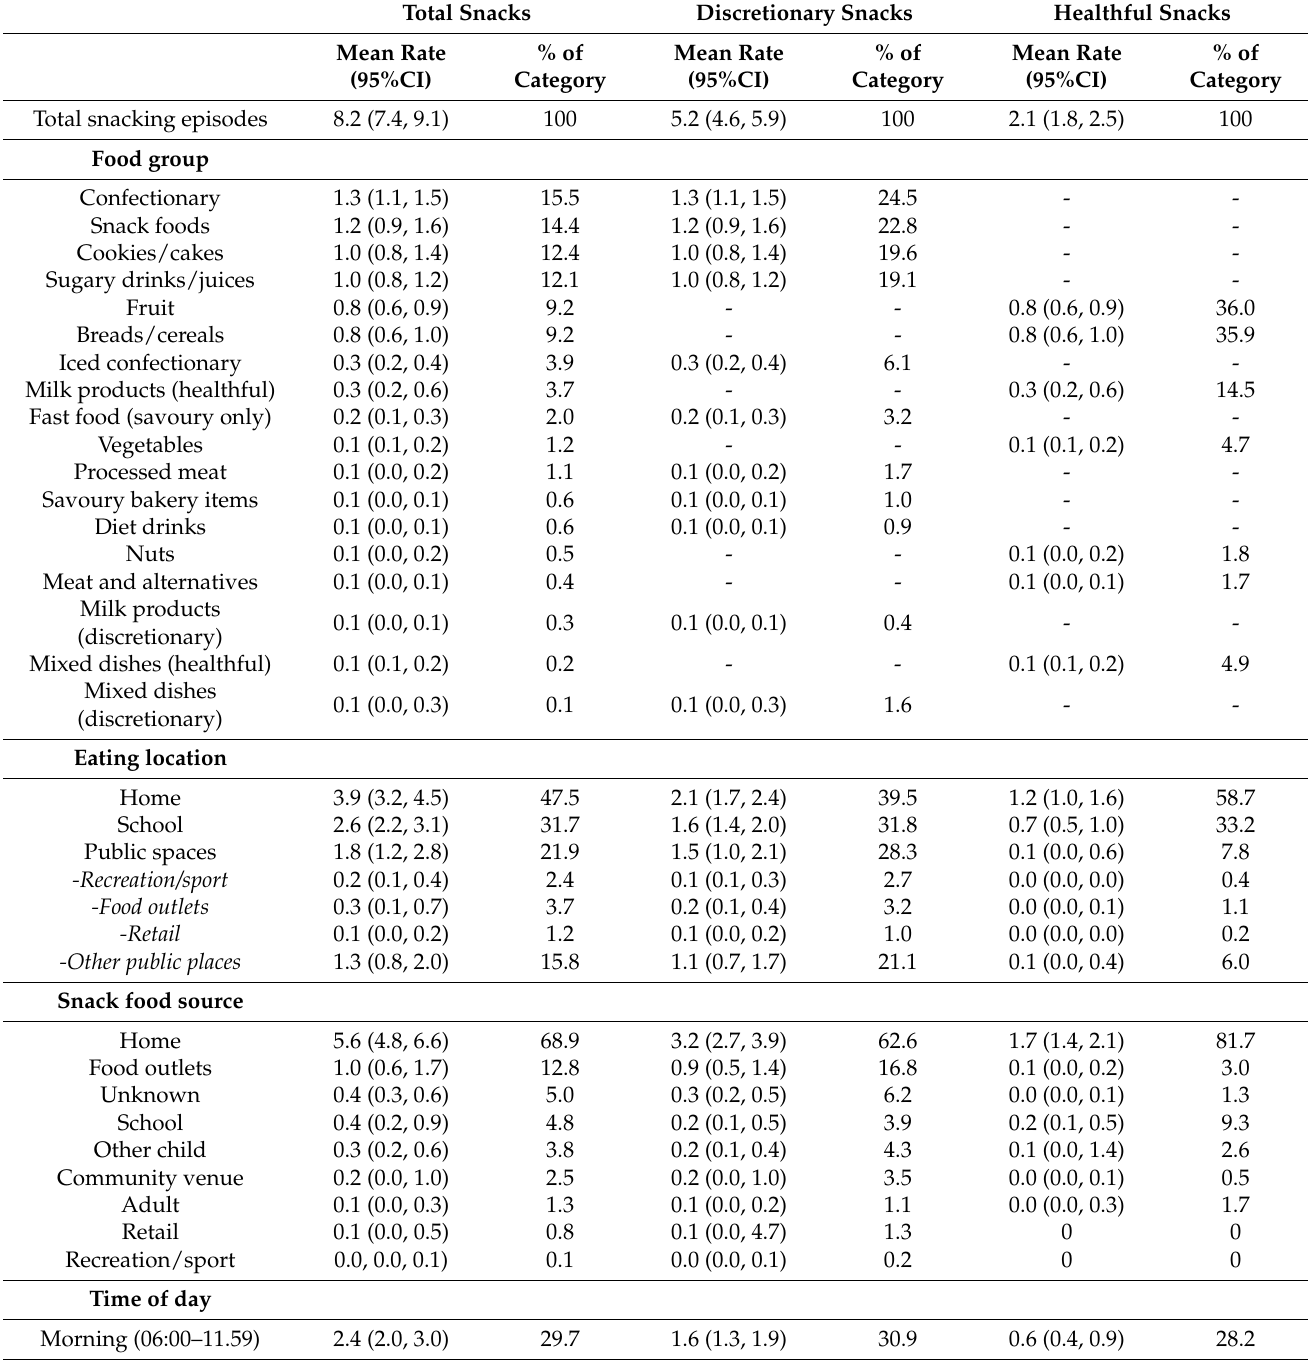
Table 2. Mean rates (95%CI) of total, discretionary and healthful snacking per 10 h by context categories, with the percentage of total snacking episodes by